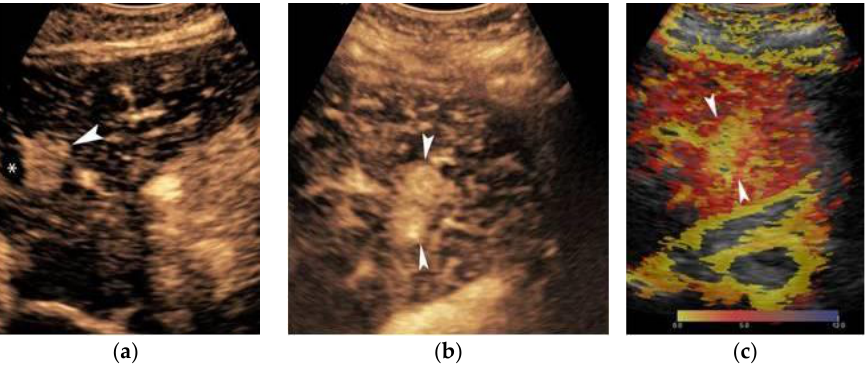
Figure 4. CEUS temporal MIP and parametric image in HCC. Sagittal arterial-phase CEUS image ( a ) showing an HCC nodule (arrowhead) developing next to a previous area of ablation (asterisk). Axial temporal MIP image ( b ) delineating the entire HCC nodule (outlined by arrowheads). Parametric colour map ( c ) confirming the earlier and homogeneous arrival of contrast in the HCC nodule.